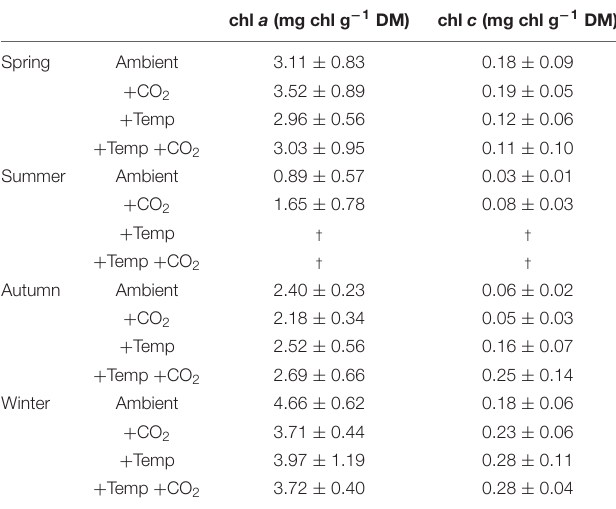
TABLE 4 | Chlorophyll a and c contents (mg chl g − 1 dry mass) of Fucus vesiculosus individuals at the end of the experiments in the Kiel Outdoor Benthocosms, with various temperature and pCO 2 conditions over different